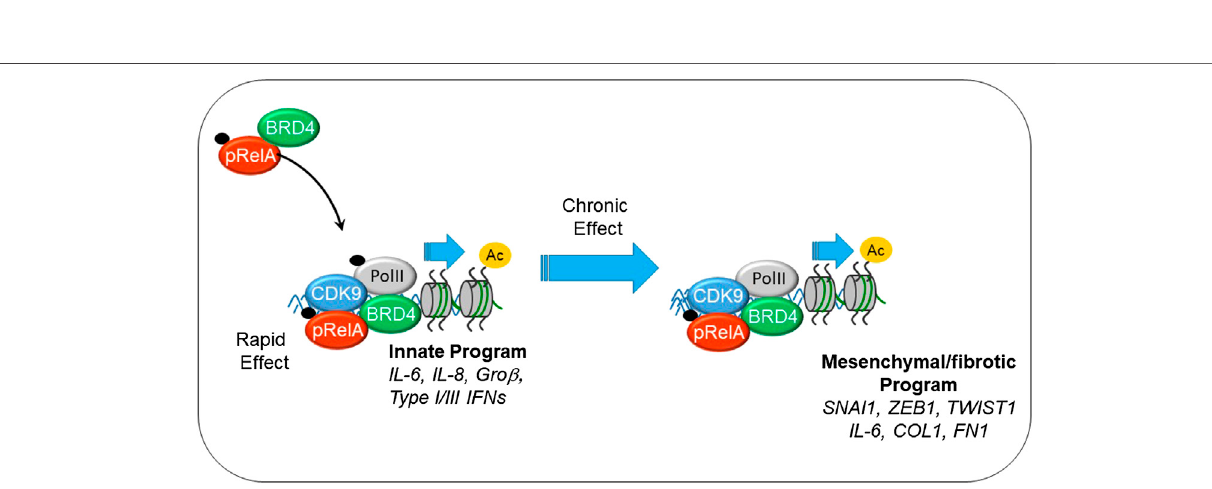
FIGURE2| MechanismshowinnatesignalingcouplestoEMT.Shown istheinteraction betweenphosphorylated65 kDaNF κ Bsubunit(pRelA),BRD4.Initiallythis chromatinremodelingcomplexactivatesinnateresponsegenesimportantinviralrestriction.Withchronicstimulation,thecomplexdirectlyactivatesSNAI,COL,FN,and other components of